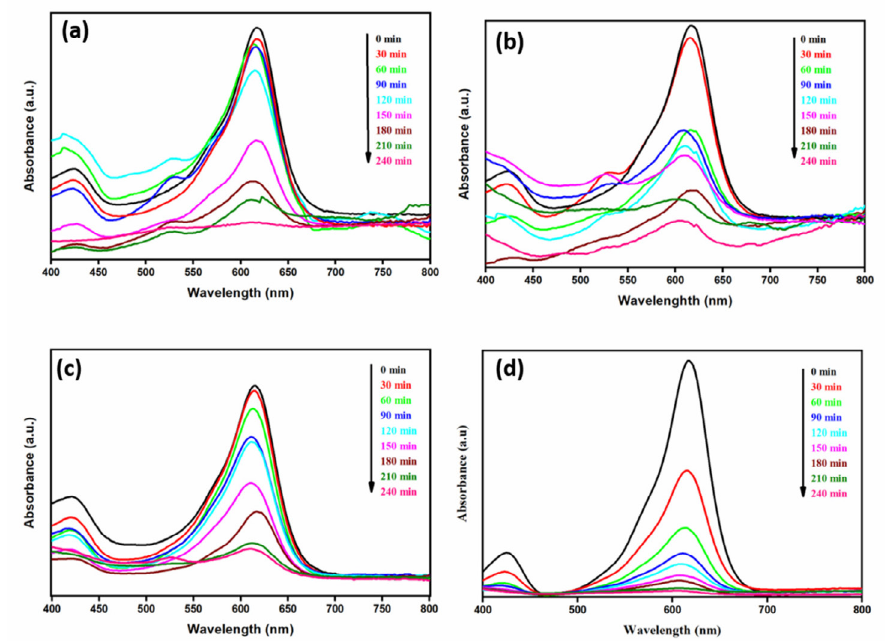
Fig. 8. UV absorbance curve on degrading the malachite green dye on adding TiO